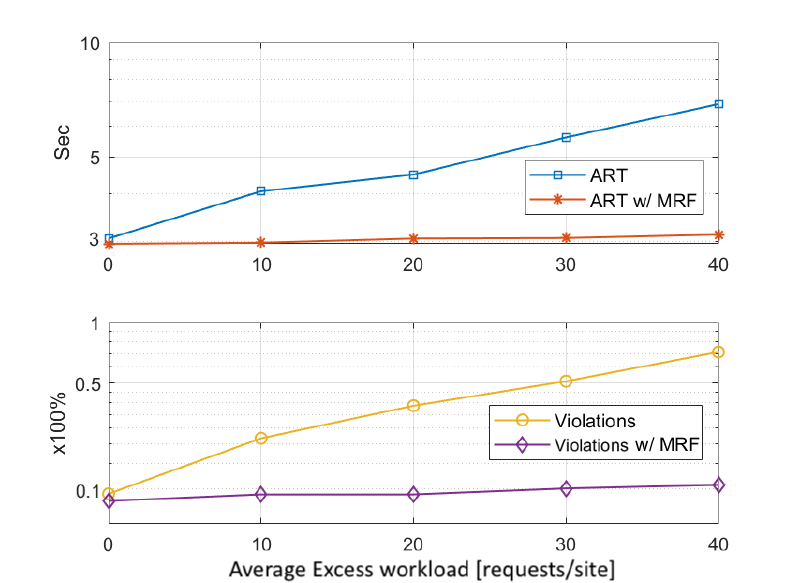
Figure 9. MRF QoS improvements for various excess workloads in overloaded sites.